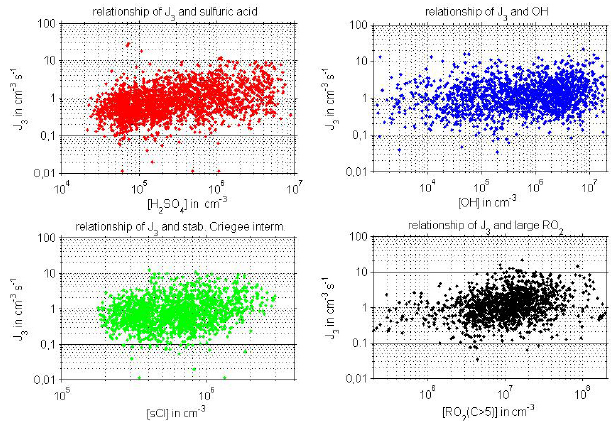
Figure 15. Scatter plots of sulfuric acid, OH, stabilised Criegee in- termediates and large organic peroxy radicals by monoterpene oxi- dation (RO 2 ( terp ) ) with the particle formation rate at 3nm.